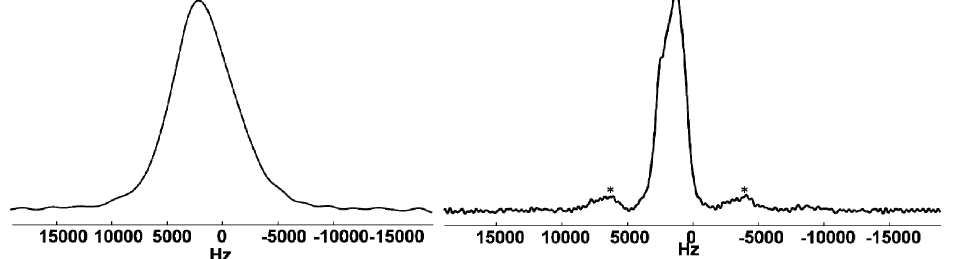
Figure 4. Static ( left ) and MAS ( right ) solid-state 2 H NMR spectra of LaGa 2 D 0.71(2) , asterisks indicating spinning sidebands. spinning